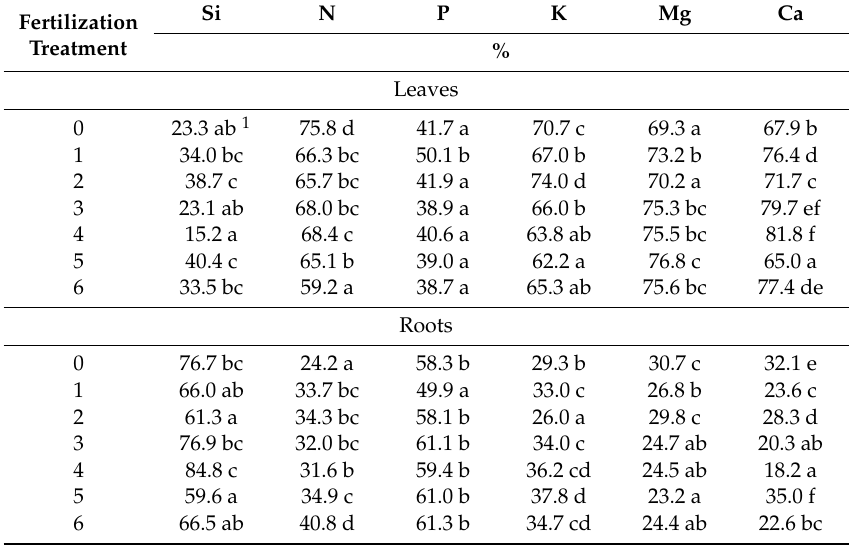
Table 3. The distribution of Si and macronutrients in sugar beet plants (mean values from 2013 to 2014).